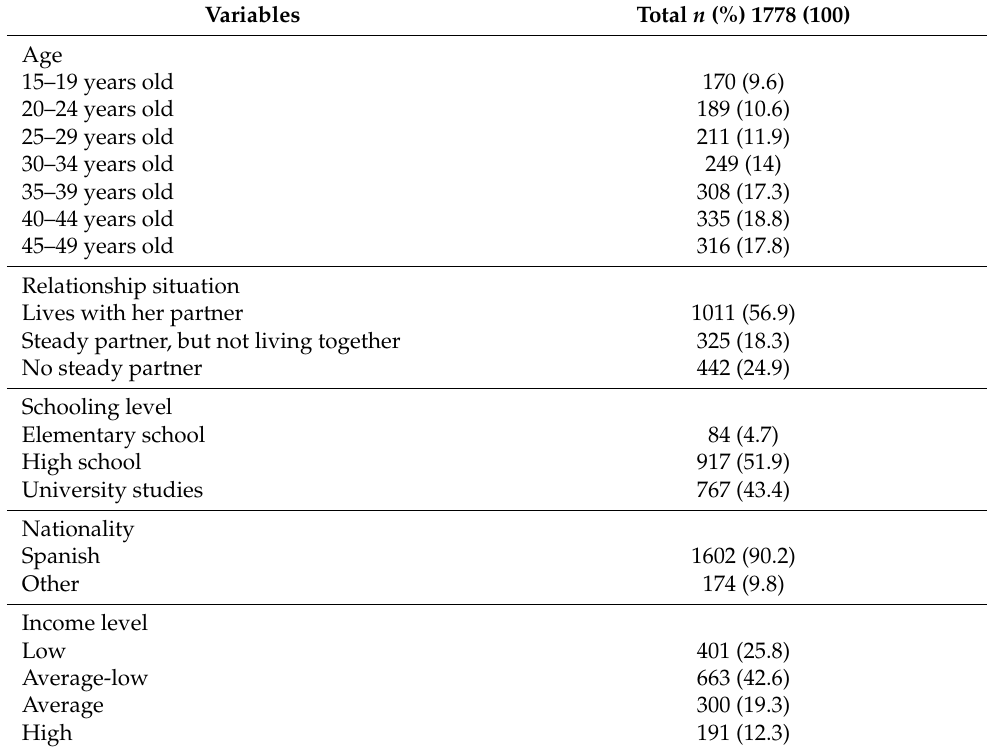
Table 1. Sociodemographic